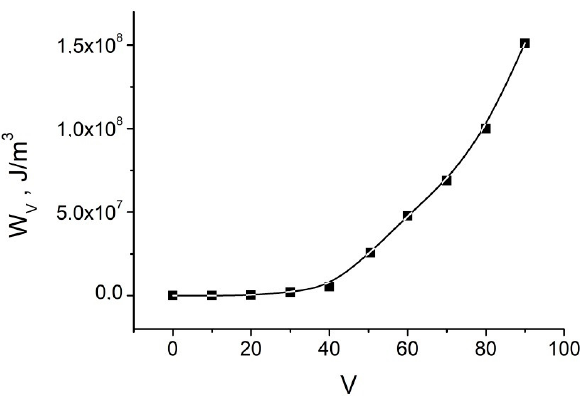
Figure 2. The energy density in the gap, measured for a thin-film capacitive motor.